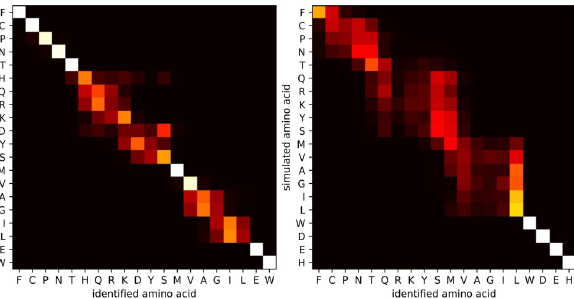
Fig 7. Heatmaps for isolated amino acid identification at pH 1.0 and 4.0. A heatmap for pH 3.0 is shown in Fig 4. (left) With pH 1.0, the average identification accuracy is 65.50%. With 10 clusters (HQRKDYS, VAGIL, and 8 singletons) the cluster identification accuracy is > 95%. (right) With pH 4.0, the average identification accuracy is 40.80%. With 5 clusters (FCPNTQRKYSMVAGIL, and 4 singletons), the cluster identification accuracy is > 95%. Sequencing simulations were done for the carboxyl terminal group, for 100 ms measurement time per terminal amino acid, and an SNR of 10.